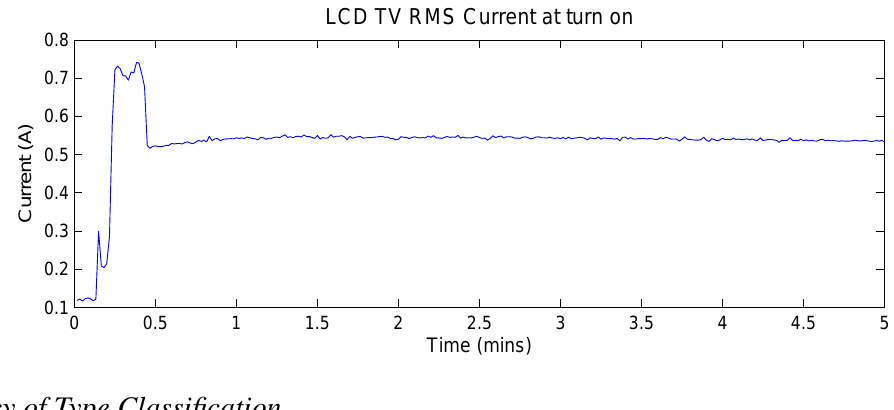
Figure 8. Root mean squared (RMS) current of the LCD television when it turns ON and a possible non-event